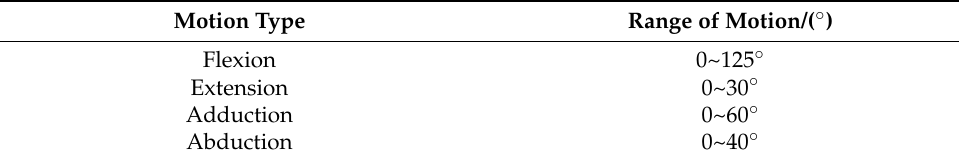
Table 3. Hip joint range of motion.